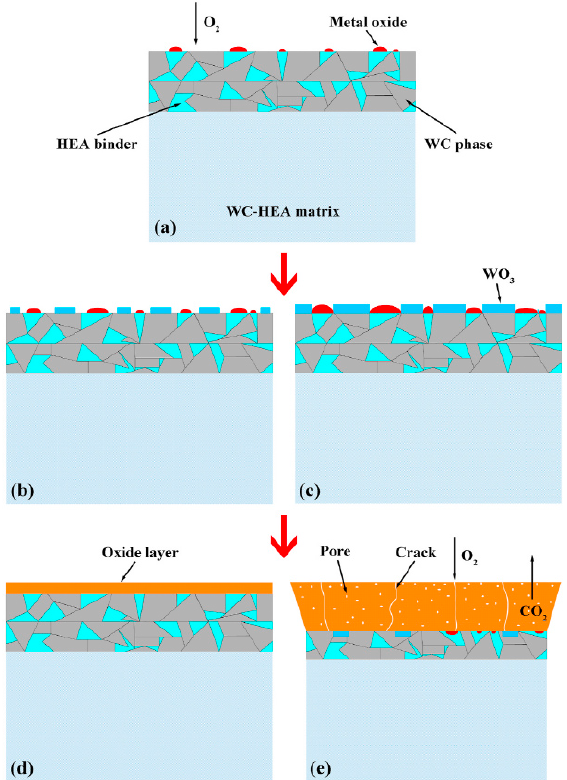
Figure 2. The schematic diagram of the oxidation process for the WC-HEA: ( a ) selective oxidation of the HEA binder phase; ( b , c ) simultaneous oxidation of the HEA and the WC phases; and ( d , e ) growth of the oxide layer accompanied by swelling. Reprinted with permission from Ref. [63].